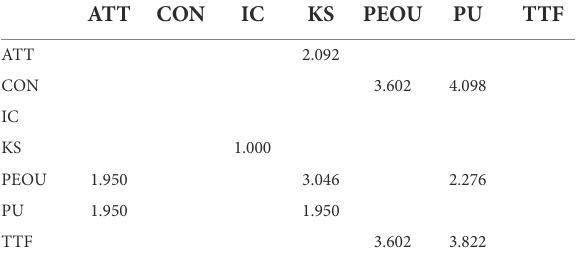
TABLE 6 Correlation and VIF